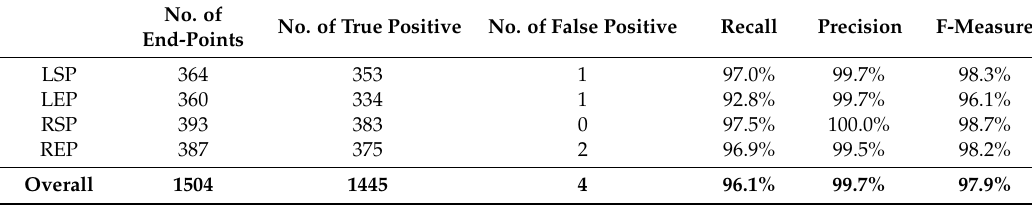
Table 5. Performance of the proposed lane endpoint detection method in daytime.